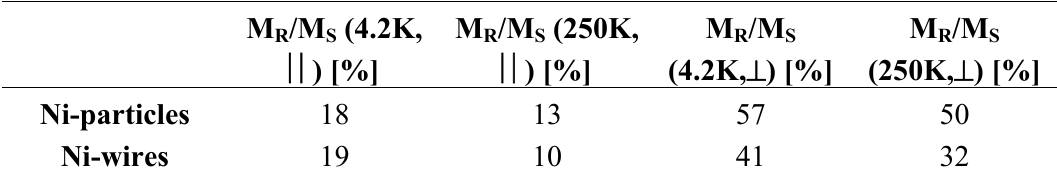
Table 4. Squareness (M temperatures (4.2 K and 250